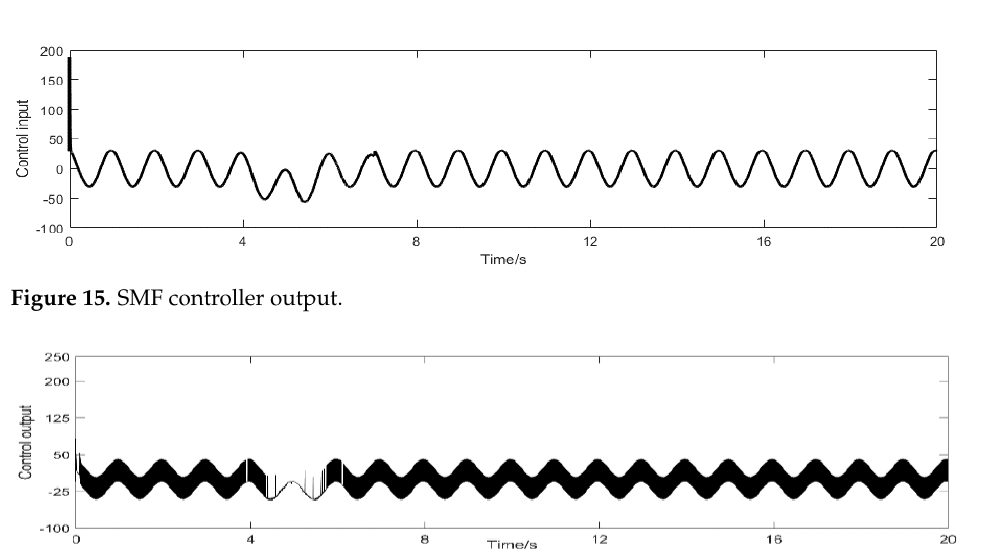
Figure 14. Y a w tracking of the standard sliding mode controller.